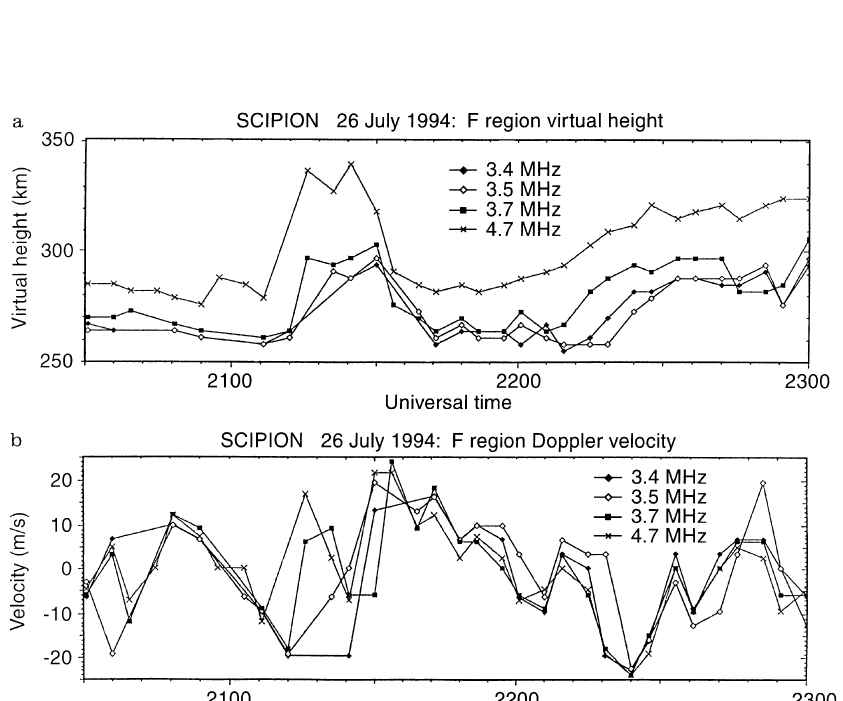
Fig. 7a–c. Data from vertical sounding measurements on sporadic-E echoes: a vir- tual height, b critical frequency and c Doppler velocity all versus time